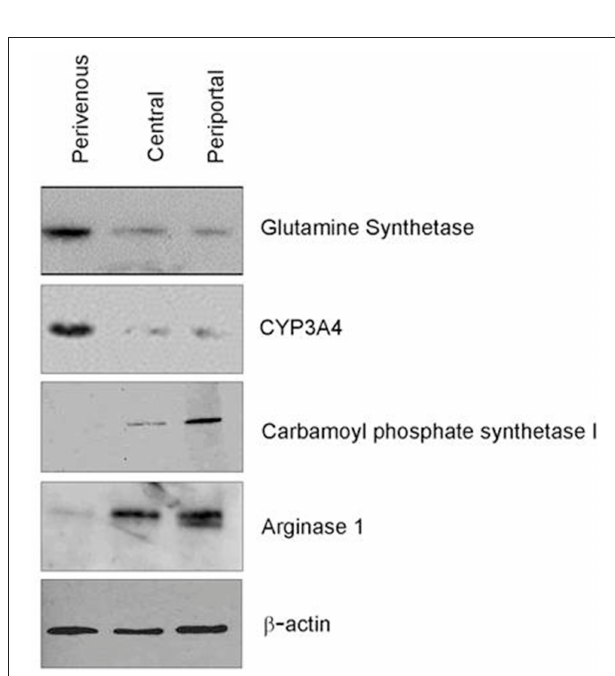
FIGURE 4 | Verification of zonation. Western blot analysis of zone specific protein markers.